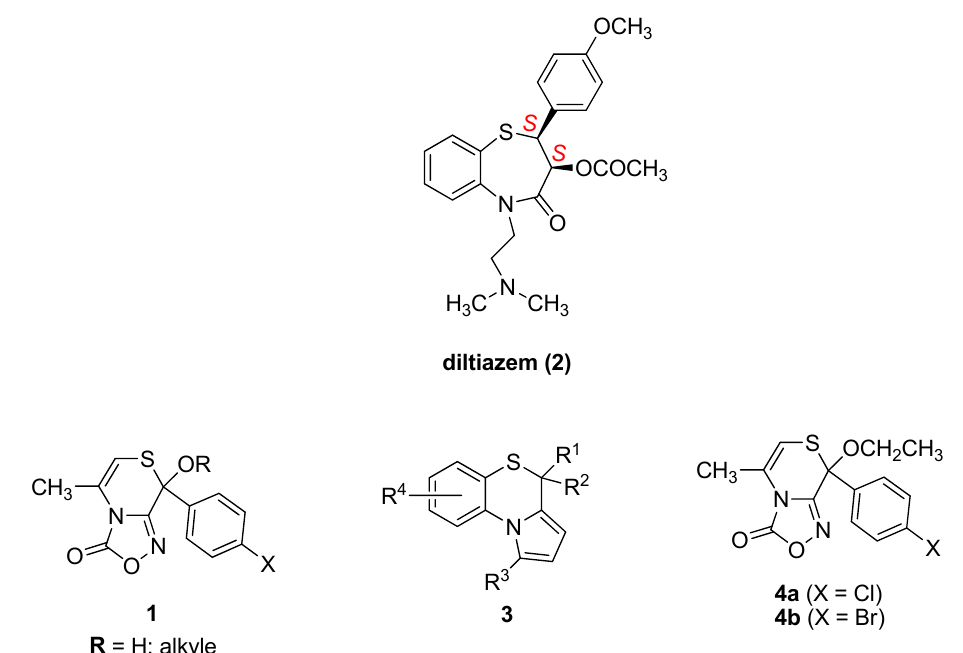
Figure 1. Chemical structure of diltiazem and related compounds purposely designed and synthesized.